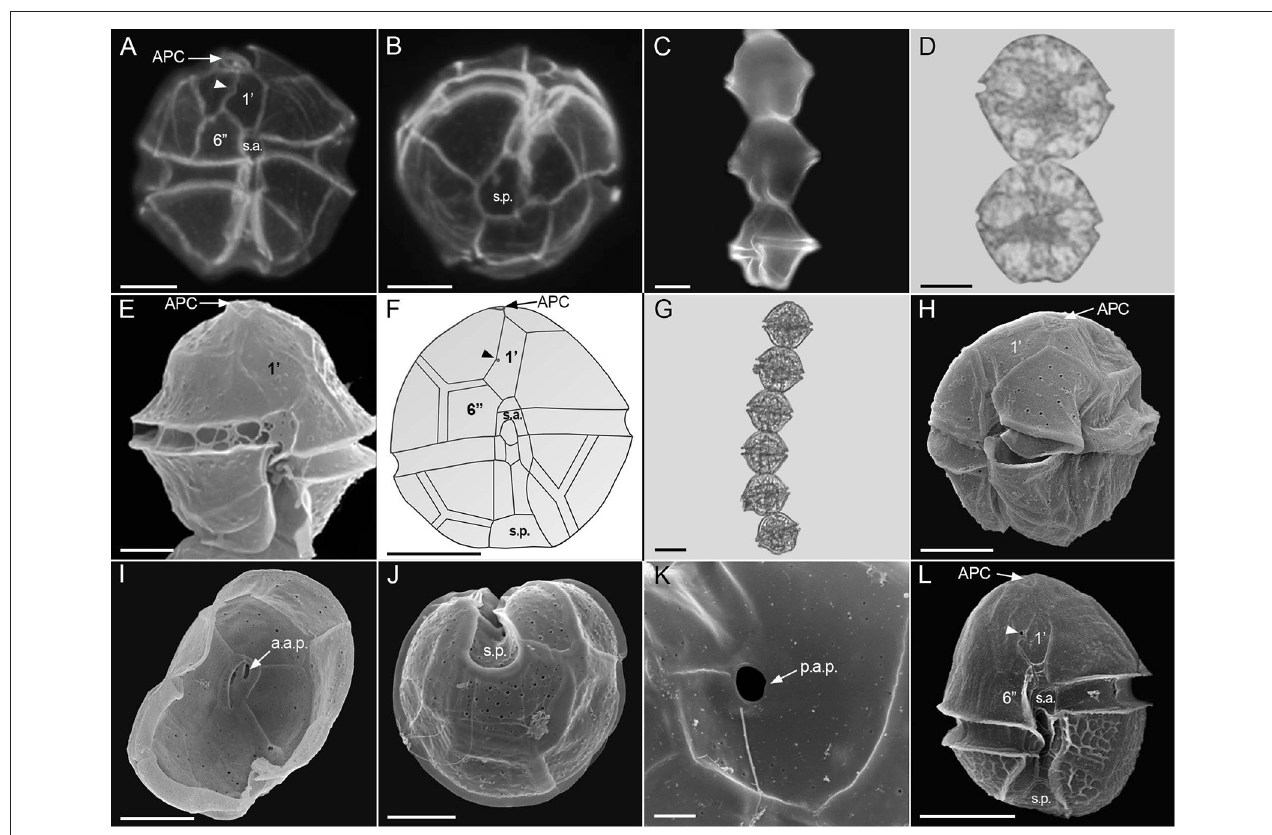
FIGURE 2 | Alexandrium species recorded from Brazil. Epifluorescence micrographs (A–C) , light micrographs (D,G) , scanning electron micrographs (E,H–L) , and drawing (F) . A. catenella in ventral view showing ventral pore (arrowhead) (A) and antapical view (B) A. fraterculus chains, (C,D) and cell in ventral view (E) , A. kutnerae in ventral view showing ventral pore (arrowhead) (F) , A. tamiyavanichi chain (G) , latero-ventral view (H) , epitheca inside showing apical pore complex with anterior attachment pore (a.a.p.) (I) , antapical view (J) , posterior sulcal plate with a large posterior attachment pore (p.a.p.) (K) , Alexandrium sp. in ventral view showing ventral pore (arrowhead) (L) . Scale = 10 µ m (A,B,E,F,H–J,L) , 20 µ m (C,D,G) , 2 µ m (K) . APC, apical pore complex; 1 ′ , first apical plate; 6 ′′ , sixth precingular plate; s.a., anterior sulcal plate; s.p., posterior sulcal plate; a.a.p., anterior attachment pore; p.a.p, posterior attachment pore. The drawing of A. kutnerae was based on Balech